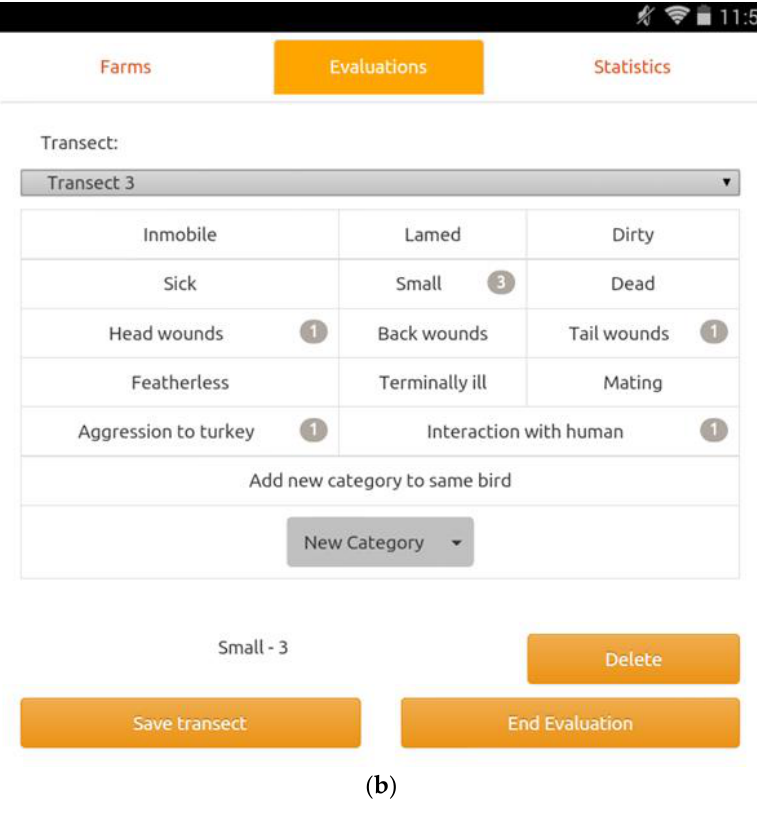
Figure 1. ( a ) The i-Watchbroiler mobile app menu screen. Major welfare indicators assessed include: lame, immobile, sick, small, dirty, terminally ill, featherless, and wounded birds; ( b ) The i-WatchTurkey mobile app menu screen, including specific welfare indicators for turkey assessment.